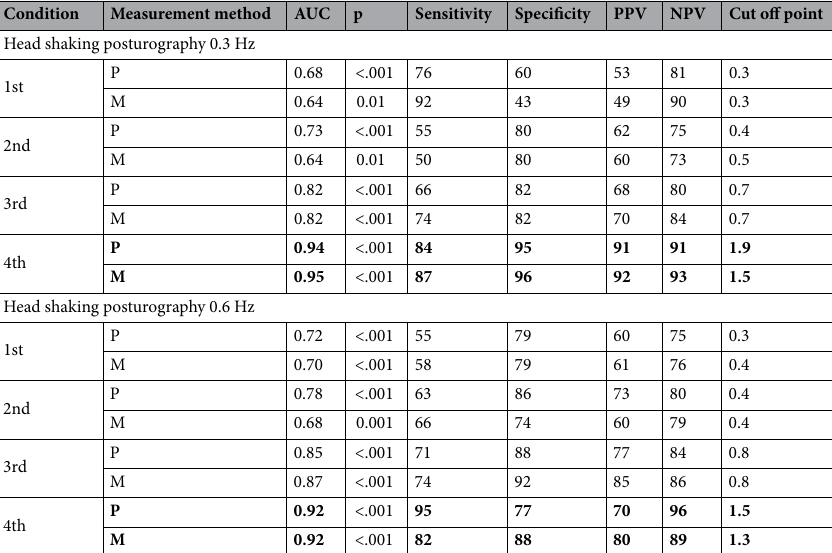
Condition Measurement method AUC p Sensitivity Specificity PPV NPV Cut off point Head shaking posturography 0.3 Hz